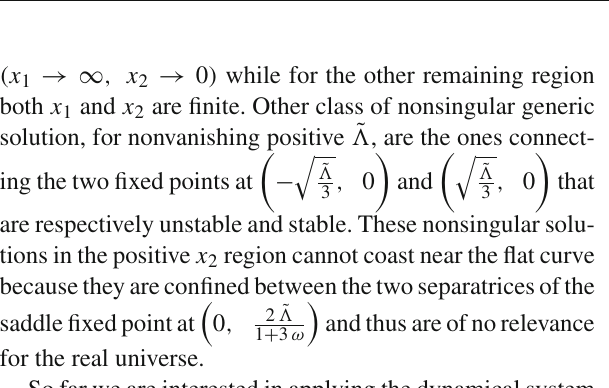
and(86),whilethecoordinatesoffixedpoints { ( x 1 ± , x 2 ± ),( x 1 , x 2 ) } are respectively defined in Eqs. (82) and (85). The eigenvalues of the Jaco- bian at the fixed points { (λ ± 1 ,λ ± 2 ),(λ 1 ,λ 2 ) } are respectively defined in Eqs. (83) and (88)